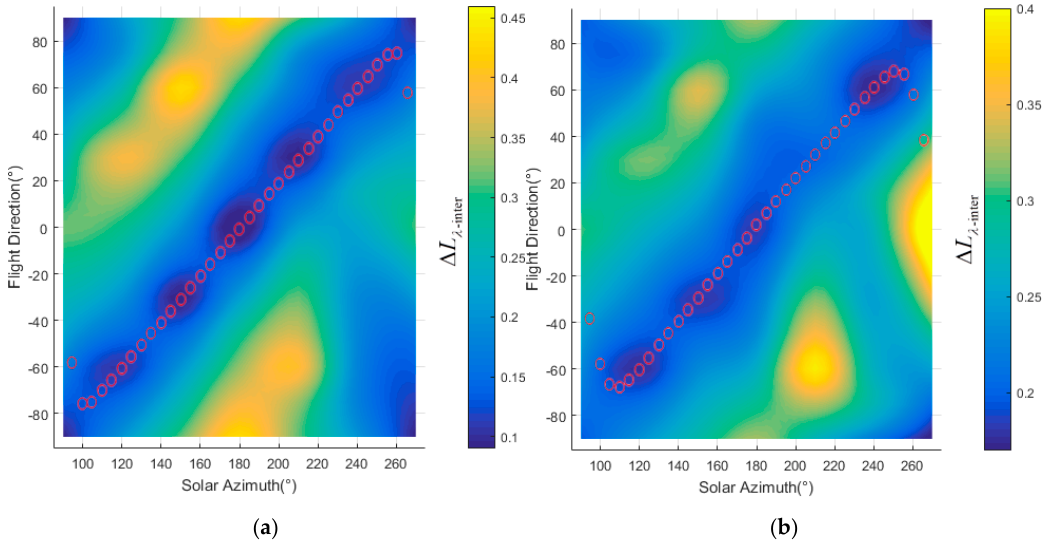
Figure 15. Radiance difference in the overlap area between adjacent stripes: ( a ) the radiance difference in zone A ( b ) the radiance difference in zone B.